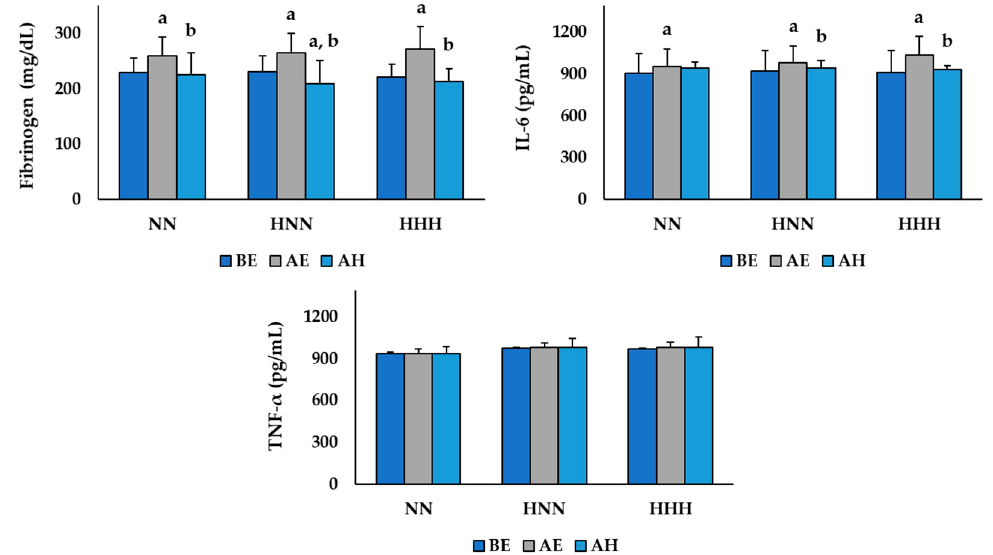
Figure 2. Changes in inflammatory markers according to HBOT after exercise in NN and HH environments. Values are mean ± standard deviation; NN: exercised in normobaric, normoxic conditions; HNN: HBOT treatment after exercising in normobaric, normoxic conditions; HHH: HBOT treatment after exercising in in hypobaric, hypoxic conditions; BE: before exercise; AE: after exercise; AH: after HBOT; IL-6: interleukin-6; TNF- α : tumor necrosis factor- α ; a Significant difference with BE ( p < 0.05); b Significant difference with AE ( p < 0.05).